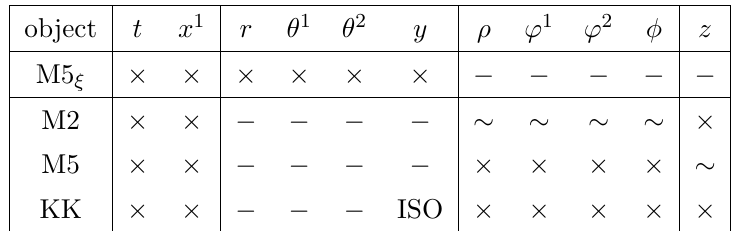
Z vacua of M-theory. 7 / k is just given by the expression (3.2), where 0